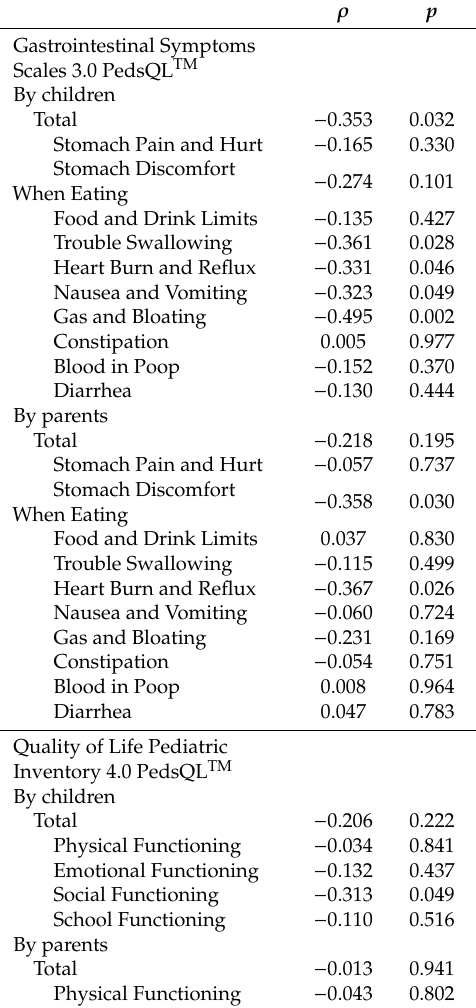
Table 2. Correlation between FC levels and Gastrointestinal symptoms scales 3.0-PedsQL TM and to the Quality of Life Pediatric Inventory 4.0-PedsQL TM scores obtained from children and their parents. ρ